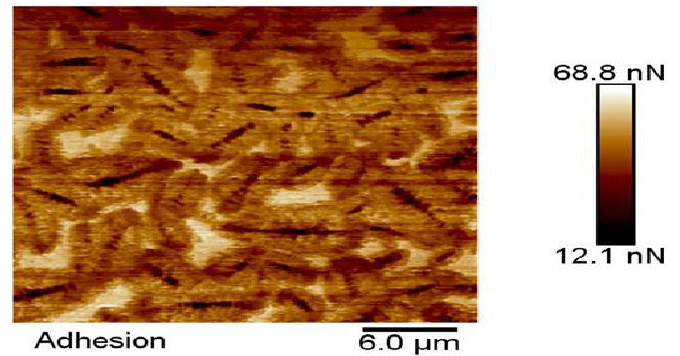
Figure 11. Micro-adhesion diagram of the asphalt binder using the DMT mode in AFM. Reprinted with permission from [76]. © 2022 The Authors. Published by Elsevier Ltd.